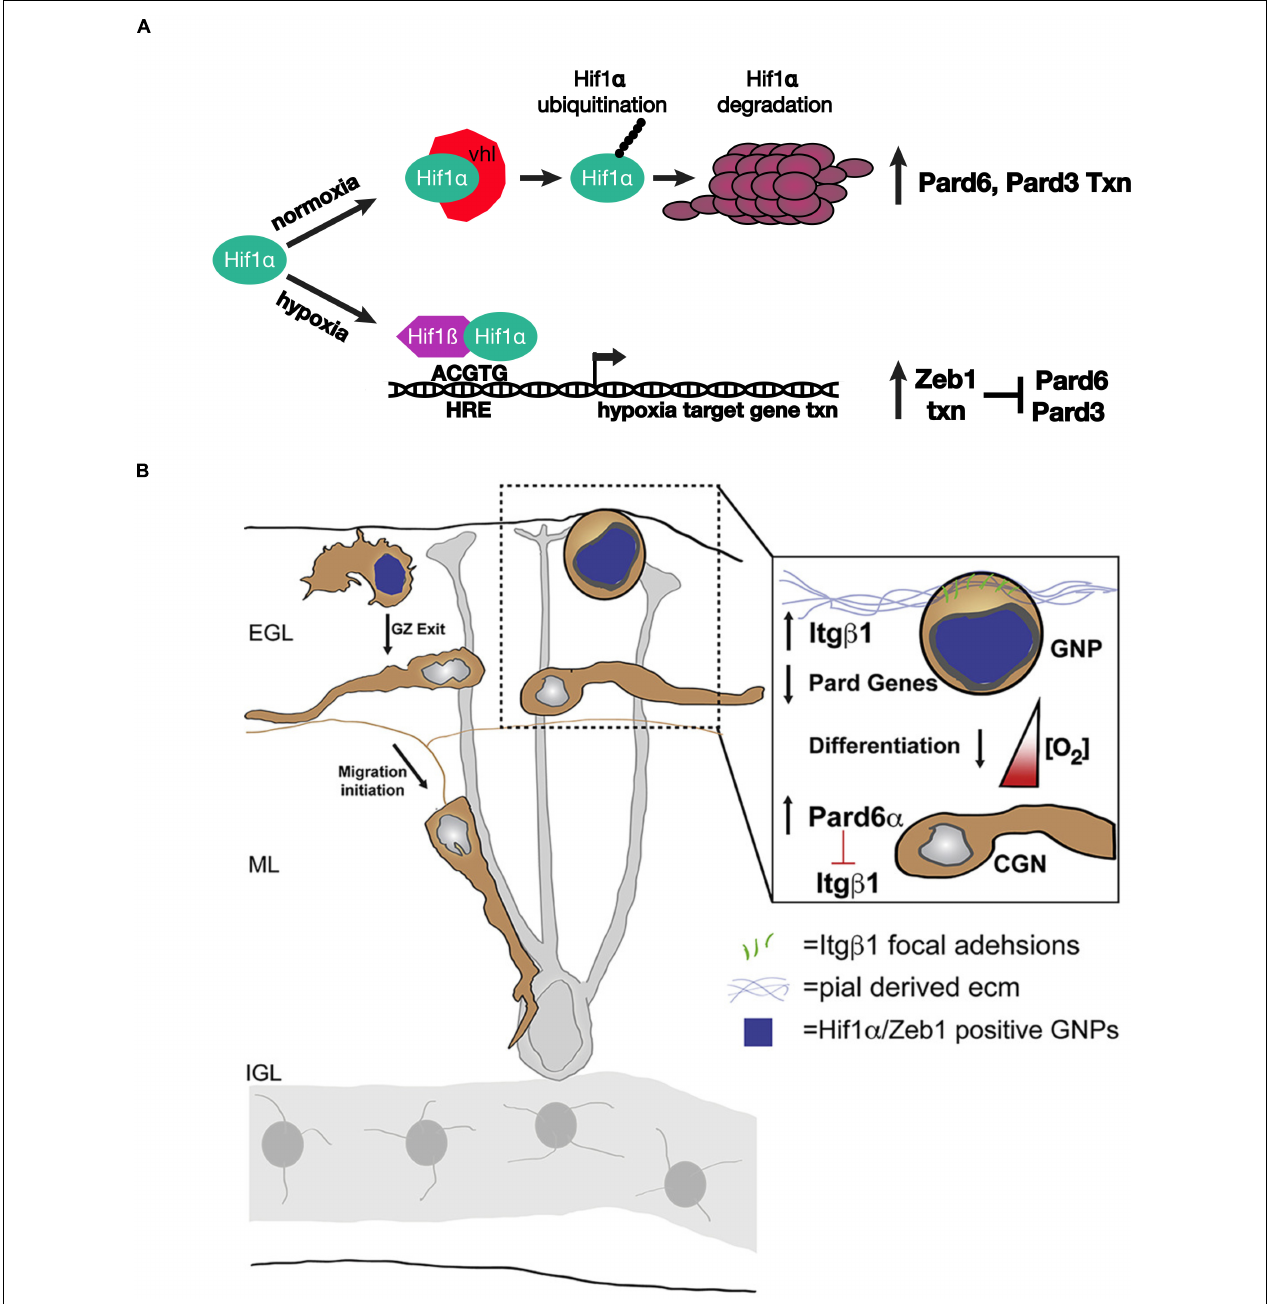
FIGURE 2 | Schematic of how oxygen tension regulates neuronal polarity in developing CGNs. (A) Model for the genetic interactions between Hif1 α , Zeb1, and the Pard proteins in hypoxia or normoxia. (B) The laminin-rich basement membrane surrounding the oEGL in a developing cerebellum. GNPs expressing Hif1 α and Zeb1 (blue nuclei) have lower level of Pard6 α gene expression. As oxygen levels increase during development Pard6 α gene expression increases which loosen Itg β 1 adhesion to the pial basal lamina. Images adapted from Kullmann et al. (2020) with permission from (Elsevier).